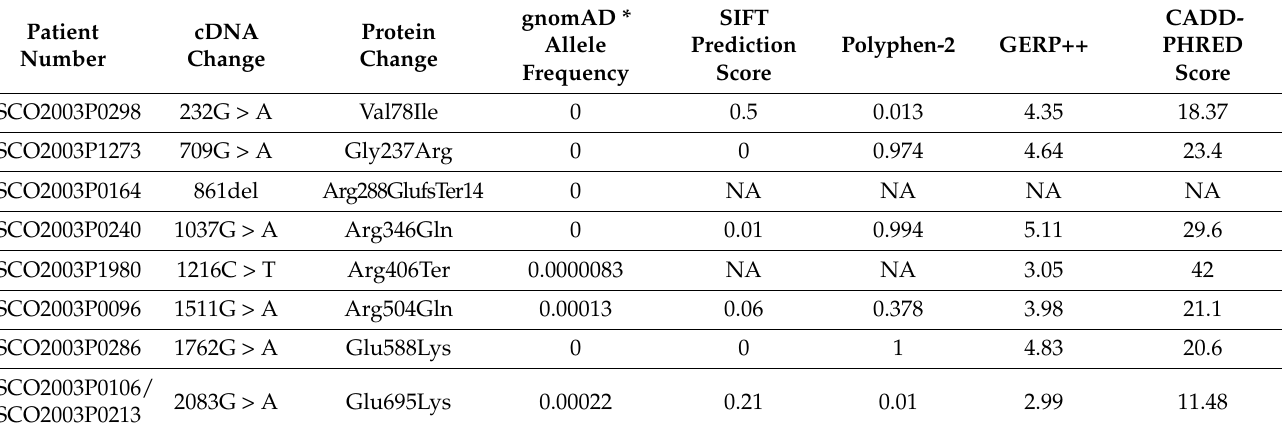
Table 2. Sequence variants in NADSYN1 and their statistics in gnomAD statistics, in silico prediction scores, and in